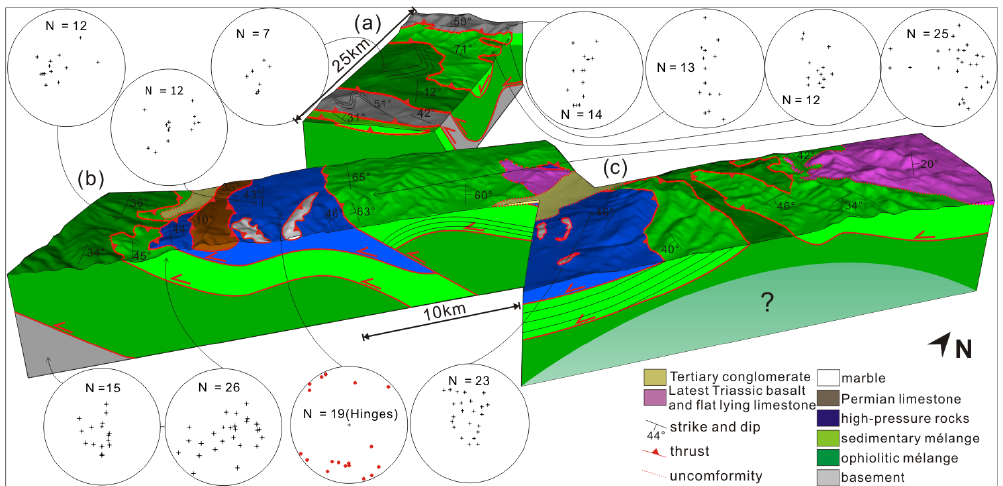
Figure 5. Three-dimensional reconstruction of selected areas near Rongma in the centre of the area showing the fold-and-thrust geometry of the three main sheets: basement, ophiolitic mélange and sedimentary mélange together with high-pressure rocks and rafts of (Permian) sediments. These are unconformably overlain by Late Triassic sediments: (a) south of Mayignag Ri, (b) northeast of Rongma and (c) northeast of Jiaomu Ri (see Fig. 1b). Lower-hemisphere equal-area stereoplots show the distribution of the main foliations (black crosses), as well as orientations of fold axes (red